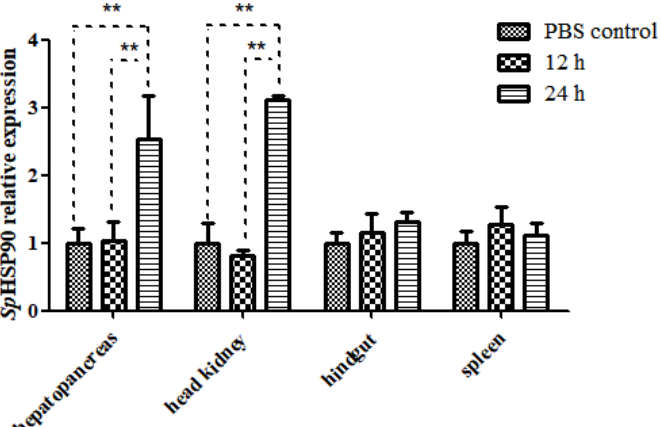
Figure 9. Transcript level of SpHSP90 at different times after LPS challenge. Each value represents a mean ± SD ( n = 4 fish per group); statistical significance was decided using one-way ANOVA followed by Tukey tests. Note: an asterisk (*) over a column represents a statistically significant difference, two for p < 0.01. n = 4.